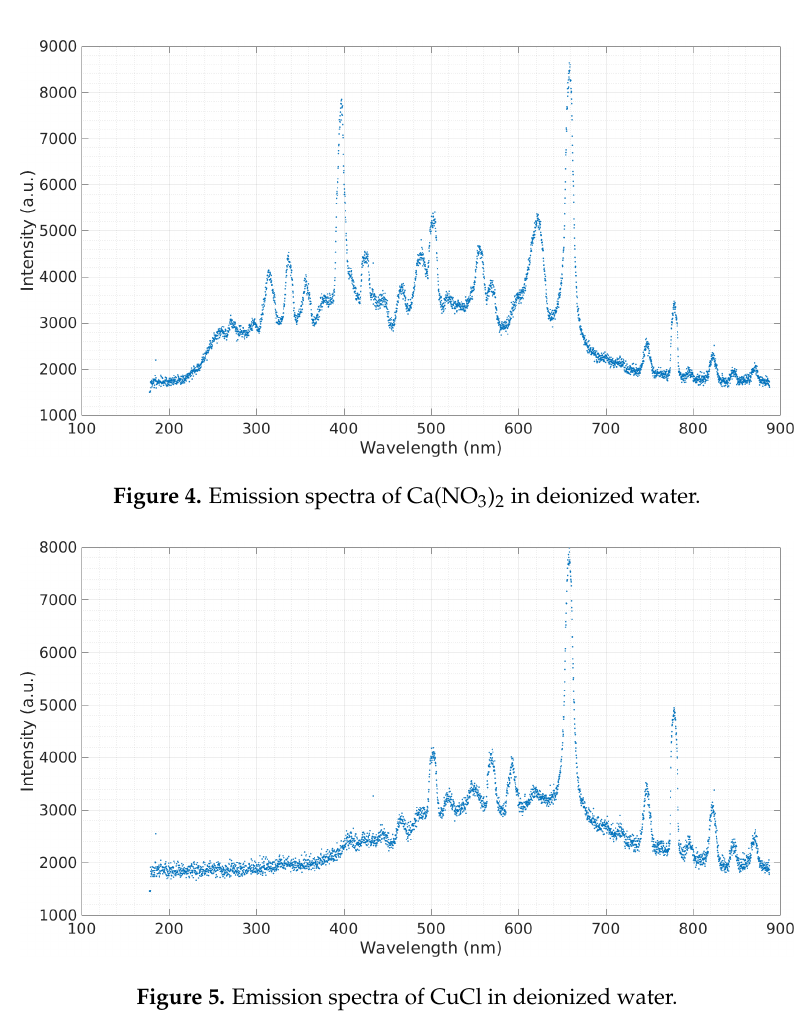
Figure 5. Emission spectra of CuCl in deionized water.